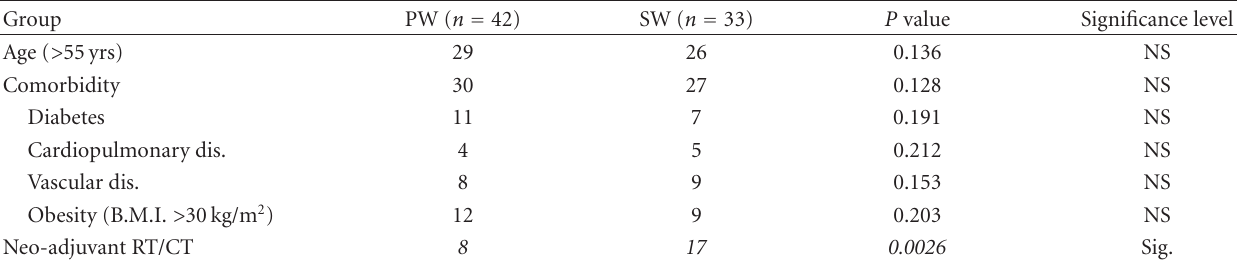
Table 2: Risk factors associated with increased morbidity after APR; comparison of the study